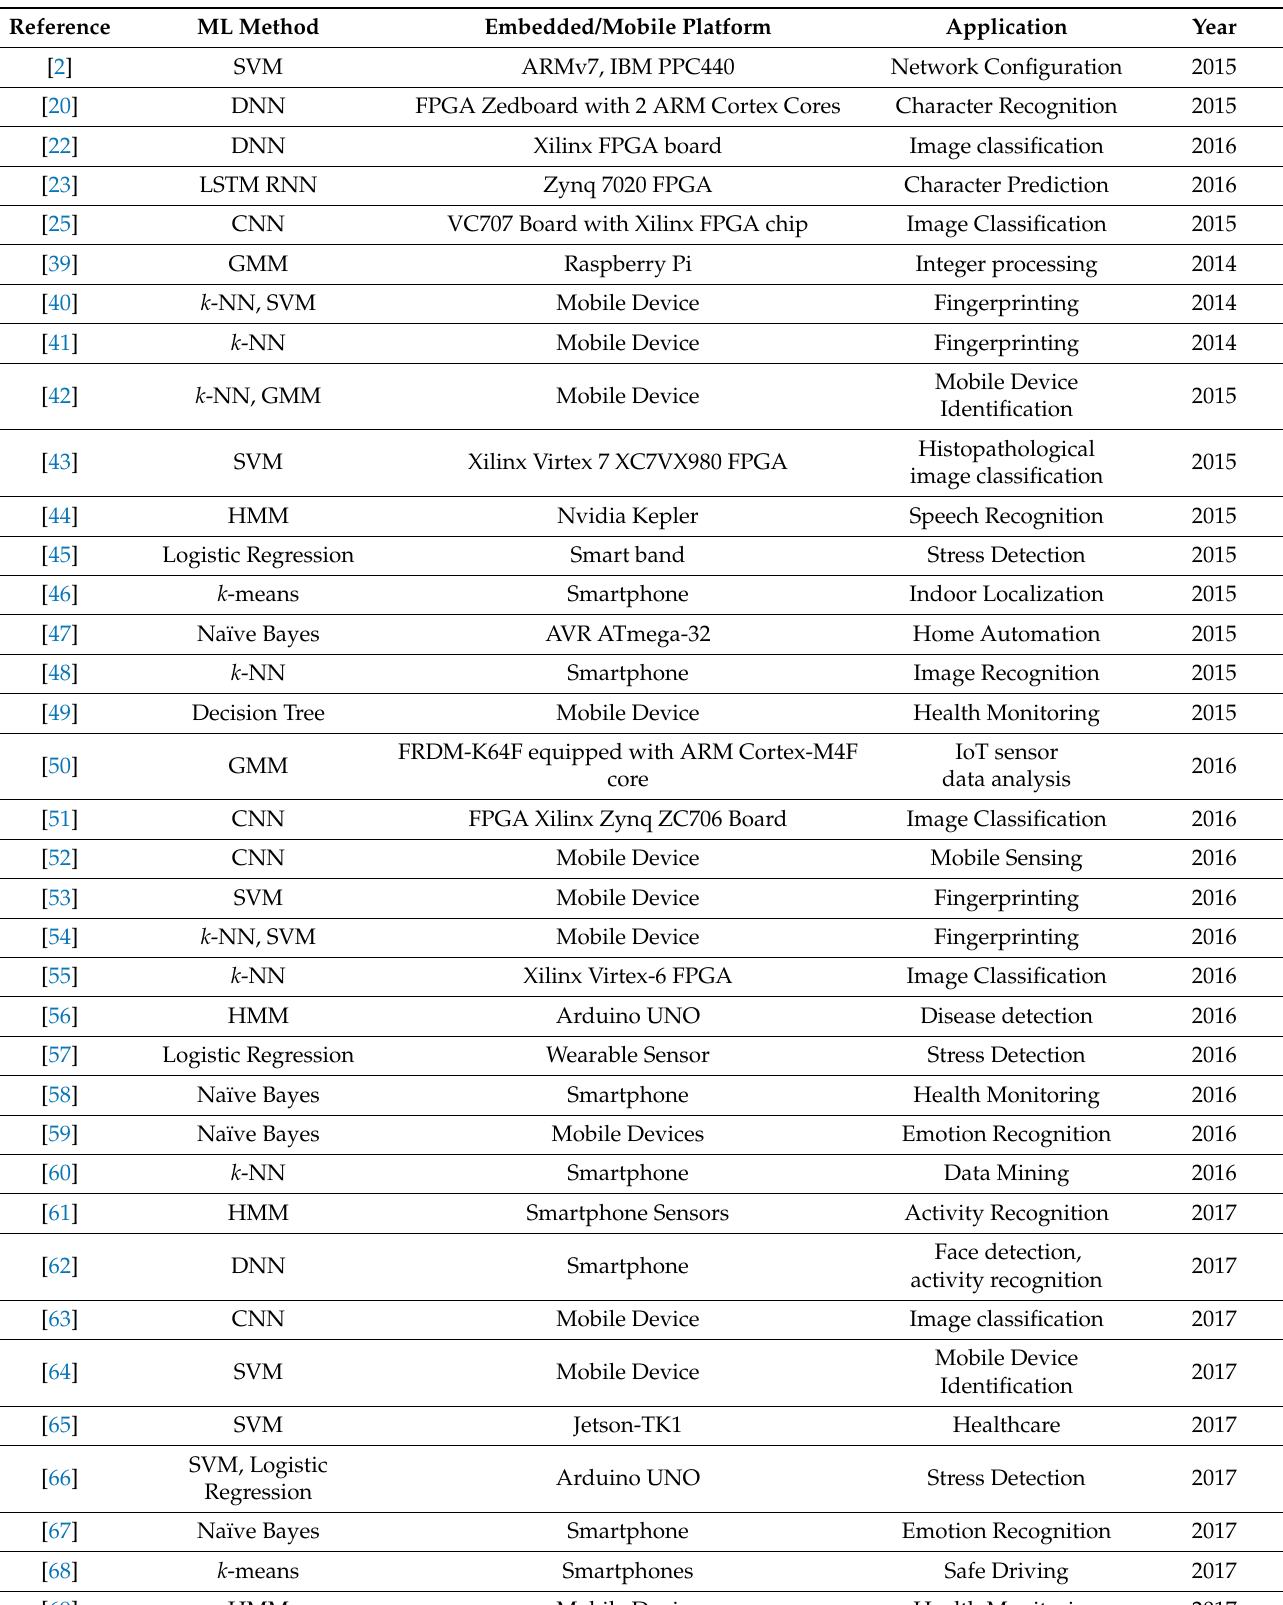
Table 2. Machine Learning Techniques in Resource-Constrained